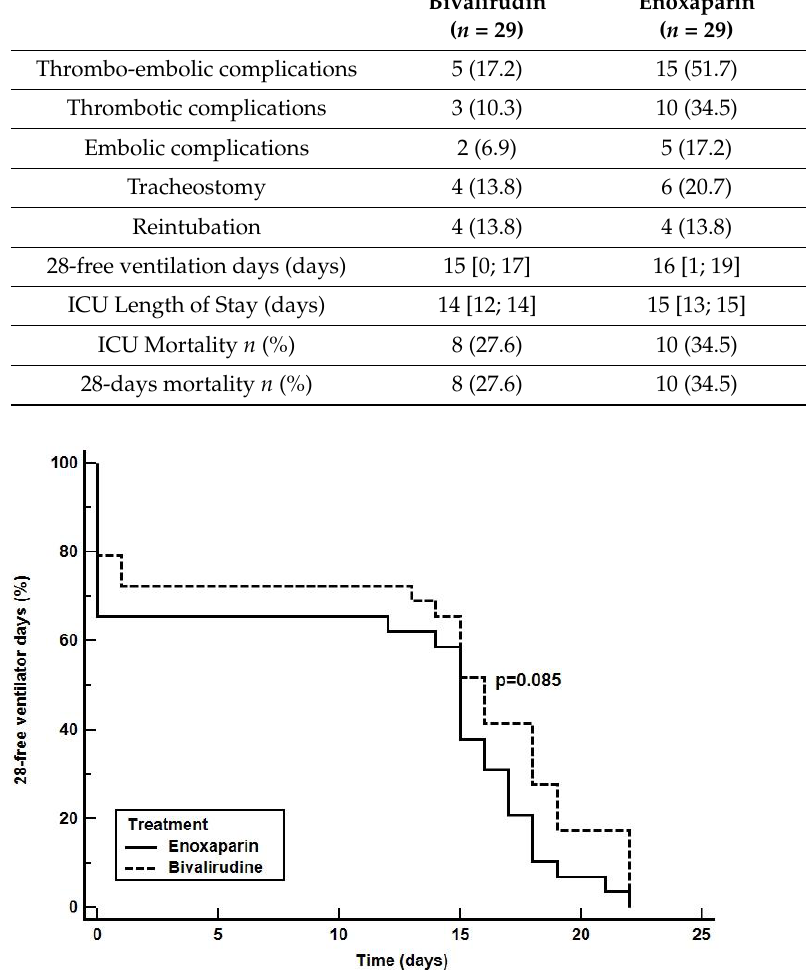
Figure 3. 28-free ventilator days. The curves depict the probability to be weaned off mechanical ventilation during 28-day of follow-up from randomization in patients receiving enoxaparin (solid line) or bivalirudin (dashed line ).